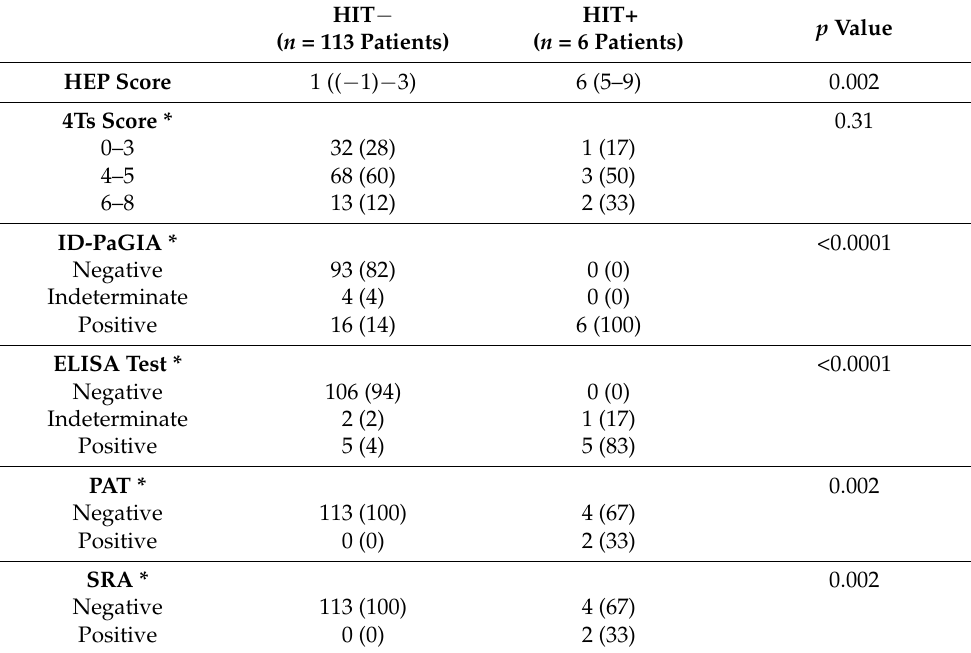
Table 2. Results of the clinical and biological diagnostic tests in the HIT+ and HIT − groups.